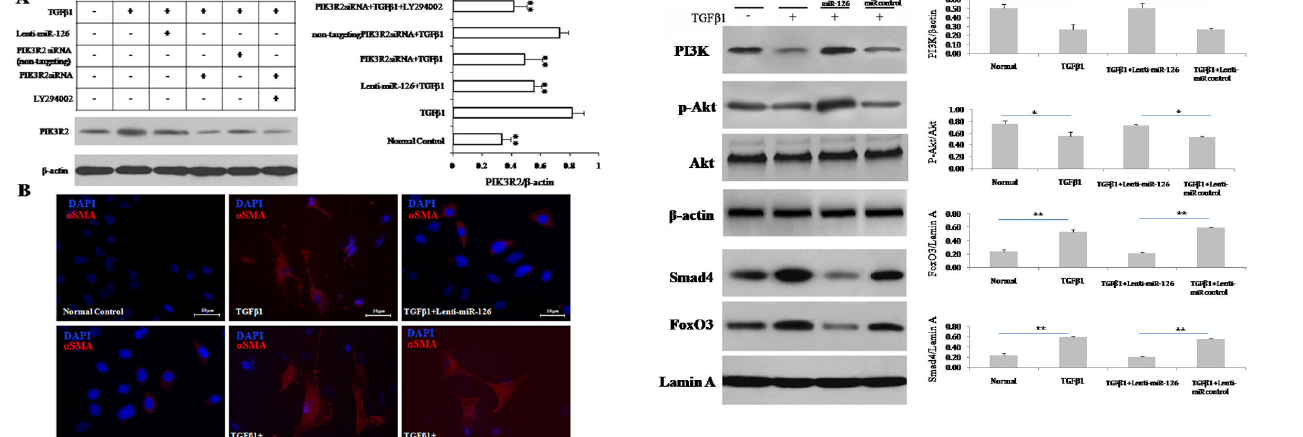
Figure 5. miR-126 activated the PI3K/Akt and inhibited the FoxO3/Smad4 signalling pathways in TGFβ1-induced EPCs. After the treatment with TGFβ1 (5 ng/mL) for 7 days, the protein in EPCs were prepared. Immunoblotting assays were performed using specific antibodies against PI3K, phosphor-Akt, Akt, FoxO3, and Smad4. β-actin and lamin A were used as internal controls for total cells and the nuclear proteins assay separately. The relative protein levels of these proteins were determined by densitometry analysis (n = 3). Data are shown as mean ± S.D. values. * and ** represent P < 0.05 and P < 0.01 with an LSD t-test, respectively. The number of observations (n) represents the number of independent cell